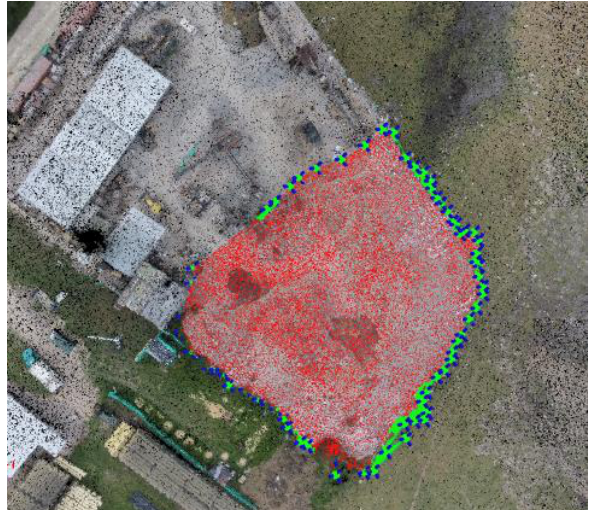
Figure 4. UAV Point cloud with stockpile drawing top view